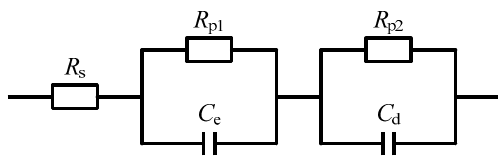
Figure 3. Equivalent circuit diagram for TA2 within.